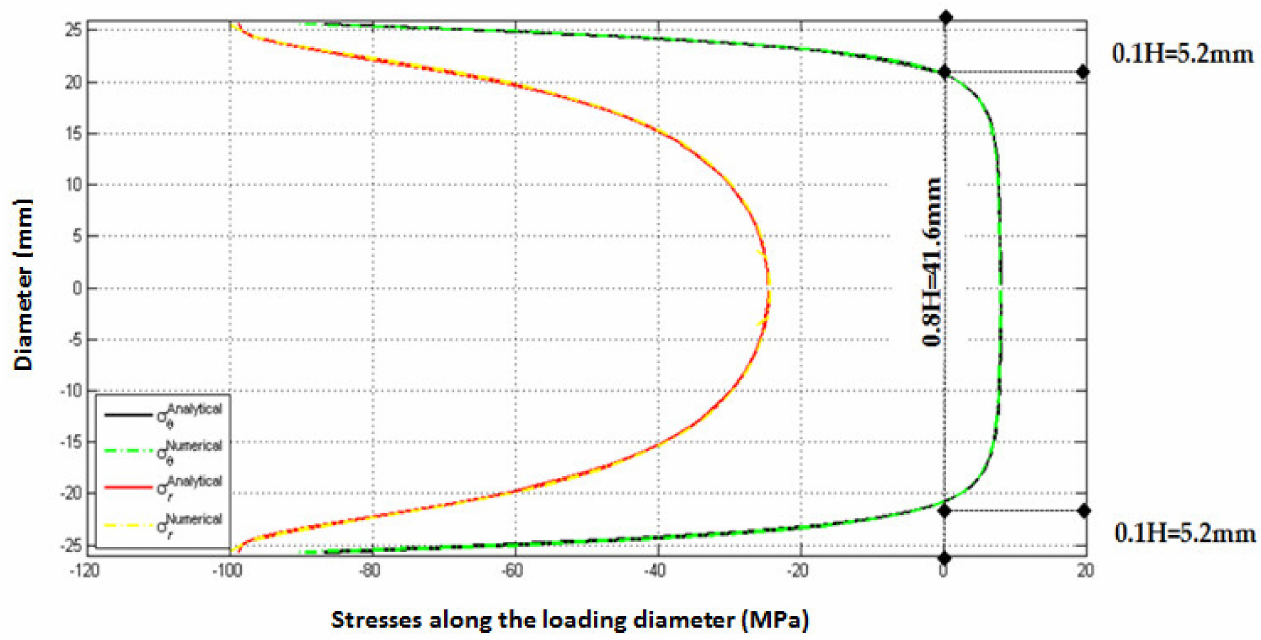
Figure 2. Distribution of vertical and horizontal stresses through the loading diameter in the disk tested by [6] in the case 2 α = 15 ◦ (compression − ,